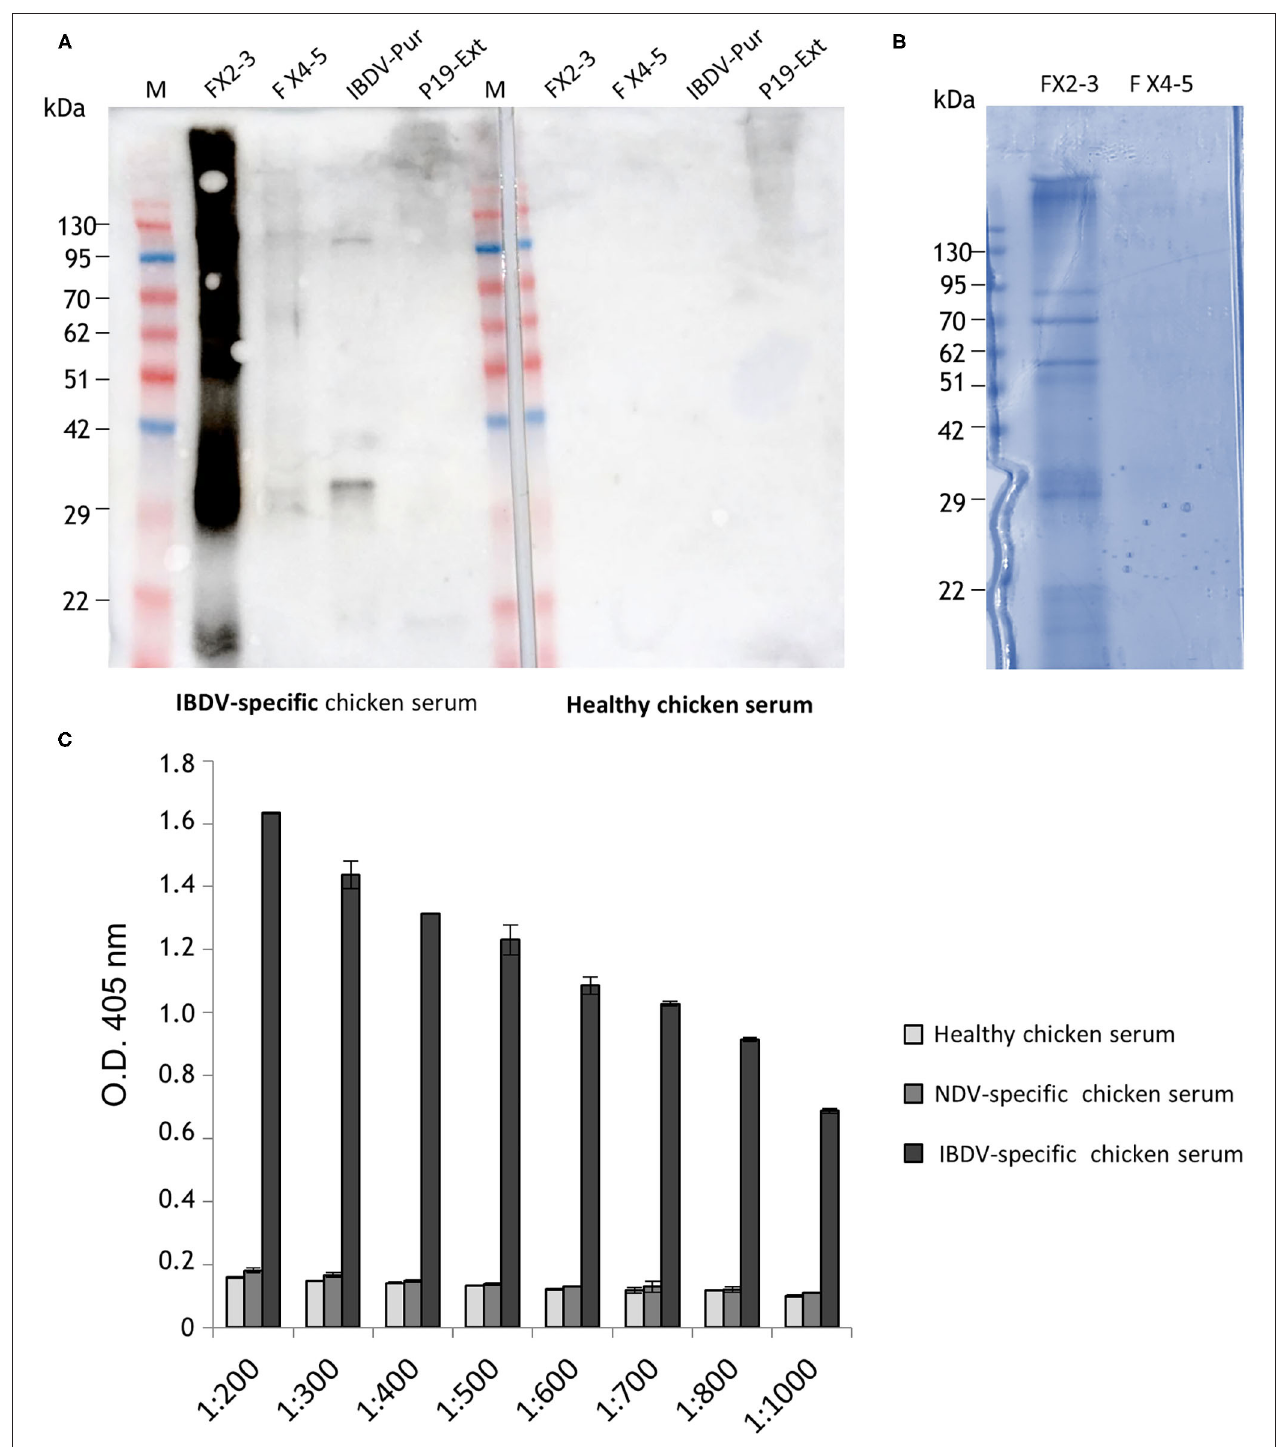
FIGURE 2 | Analysis of plant-purified His-VP3. (A) Western blot analysis with the serum of IBDV-infected chickens of fractions obtained from IMAC and concentrated. Aliquots of the pools of Fractions 2 and 3 (FX2-3) and Fractions 4 and 5 (FX4-5) were loaded on the gel (left side of the membrane). IBDV-Pur: Purified inactivated IBDV was used as positive control; P19 Ext: extract of leaves agroinfiltrated only with P19 (negative control). The same samples were also assayed using as primary antibody the serum from healthy chickens (a negative chicken serum, right side of the membrane). M: A protein molecular weight marker. (B) FX2-3 and FX4-5 fractions (10 µ l) separated under reducing conditions on Coomassie Blue-stained 12% SDS-PAGE. (C) Direct ELISA using a purified His-VP3 coated plate (30 ng per well) and serial dilutions (1:200 to 1:1,000) of an anti-IBDV chicken serum (IBDV serum) as a primary antibody. Sera from healthy chickens (negative serum) or chickens infected with an unrelated virus (Newcastle Disease Virus- NDV serum) were used as controls. The reported values are the mean of two independent experiments, and error bars represent the SD of the means.